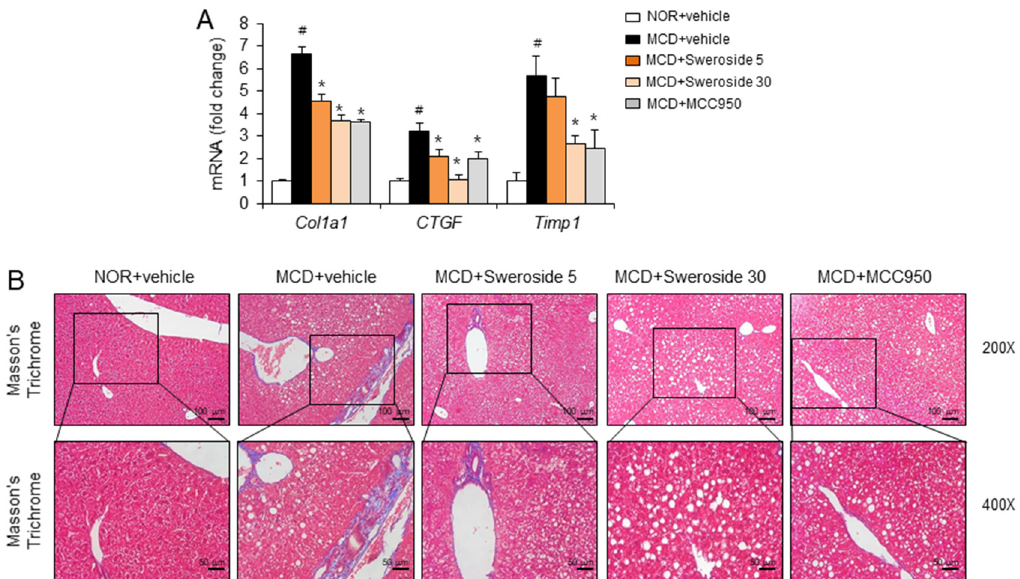
Figure 5. Sweroside alleviates hepatic fibrosis in mice fed an MCD diet. Samples were obtained from the mice described in Figure 3. ( A ) Hepatic mRNA expression of collagen type 1 ( Col1a1 ), connective tissue growth factor ( CTGF ), and a tissue inhibitor of matrix metalloproteinase 1 ( Timp1 ). The values represent means ± SEM ( n = 8). #, significantly different from NOR + vehicle, p < 0.05. *, significantly different from MCD + vehicle, p < 0.05. ( B ) Representative pictures of Masson’s trichrome-stained liver sections (200 × and 400 × ).